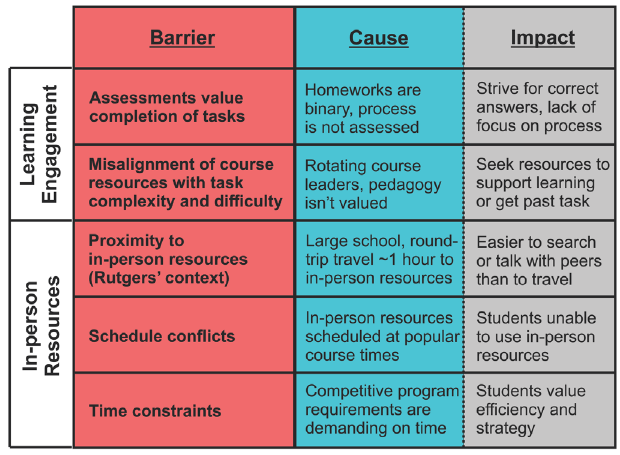
FIG. 14. Patterns of student-reported barriers to in-person resources and to more deeply engaging in their learning, extracted from interviews, N ¼ 11